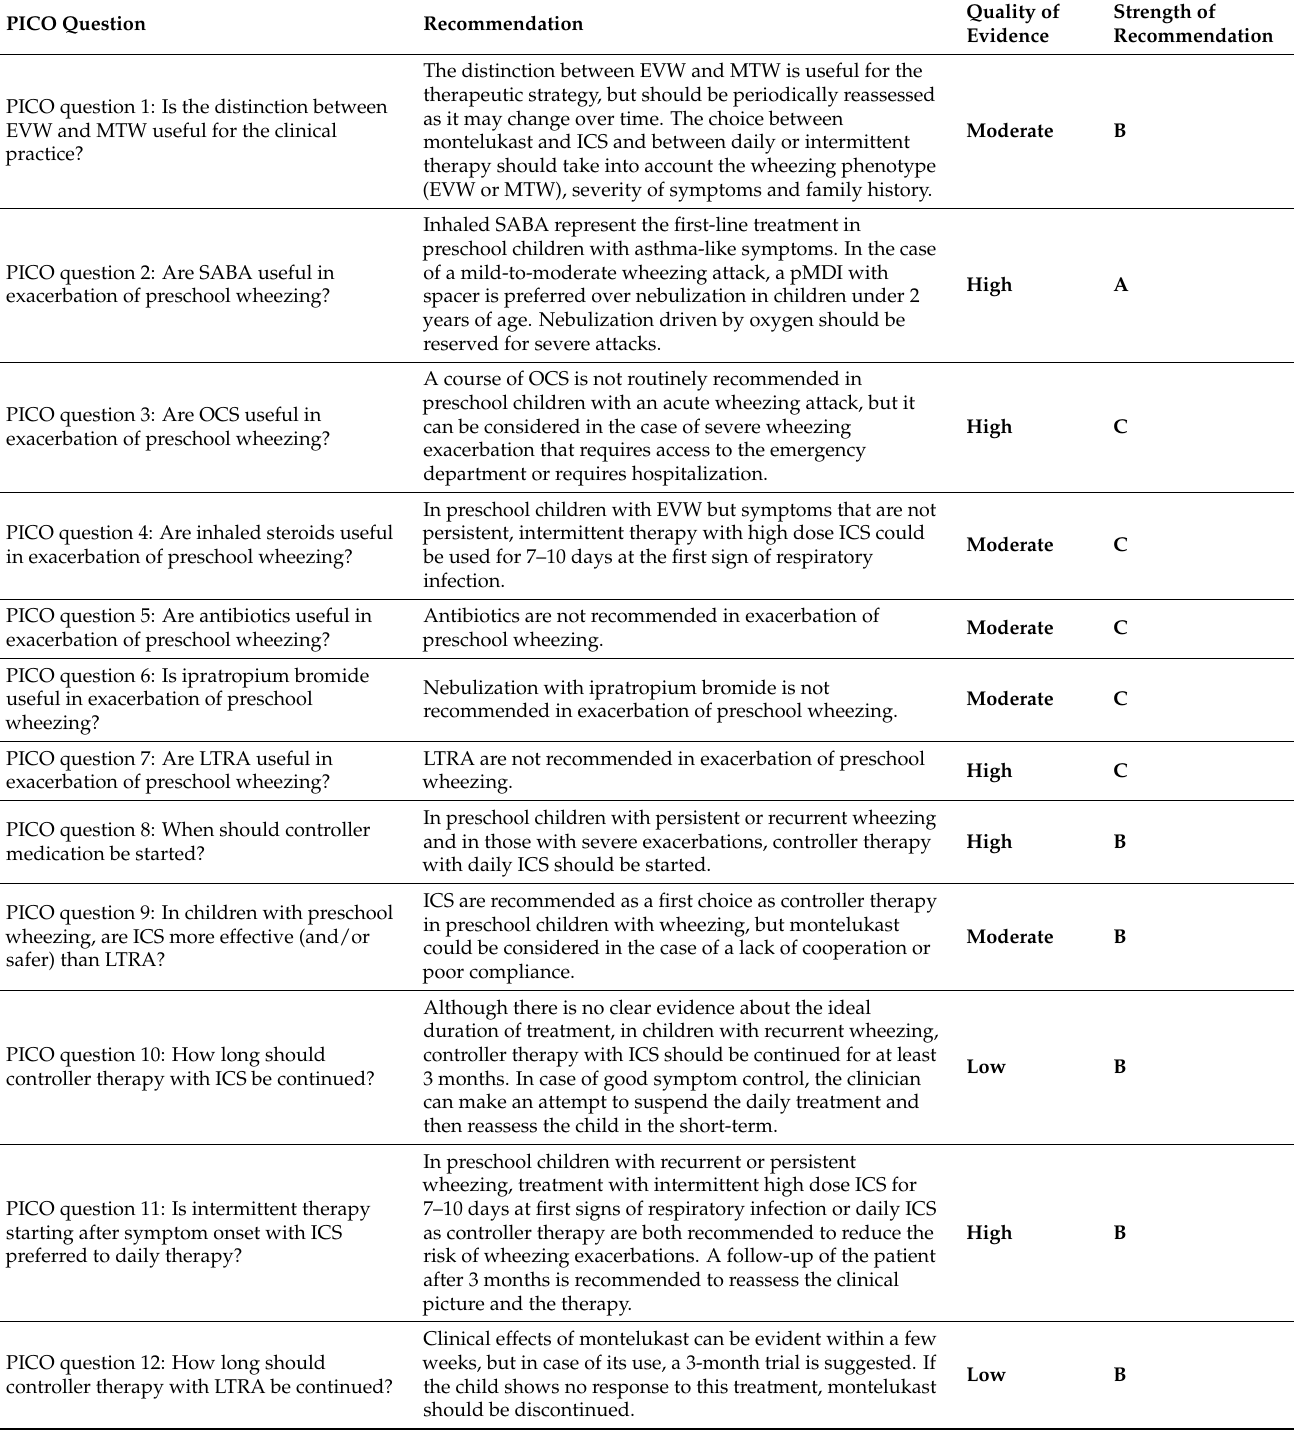
Table 1. Recommendations for clinical management of preschool